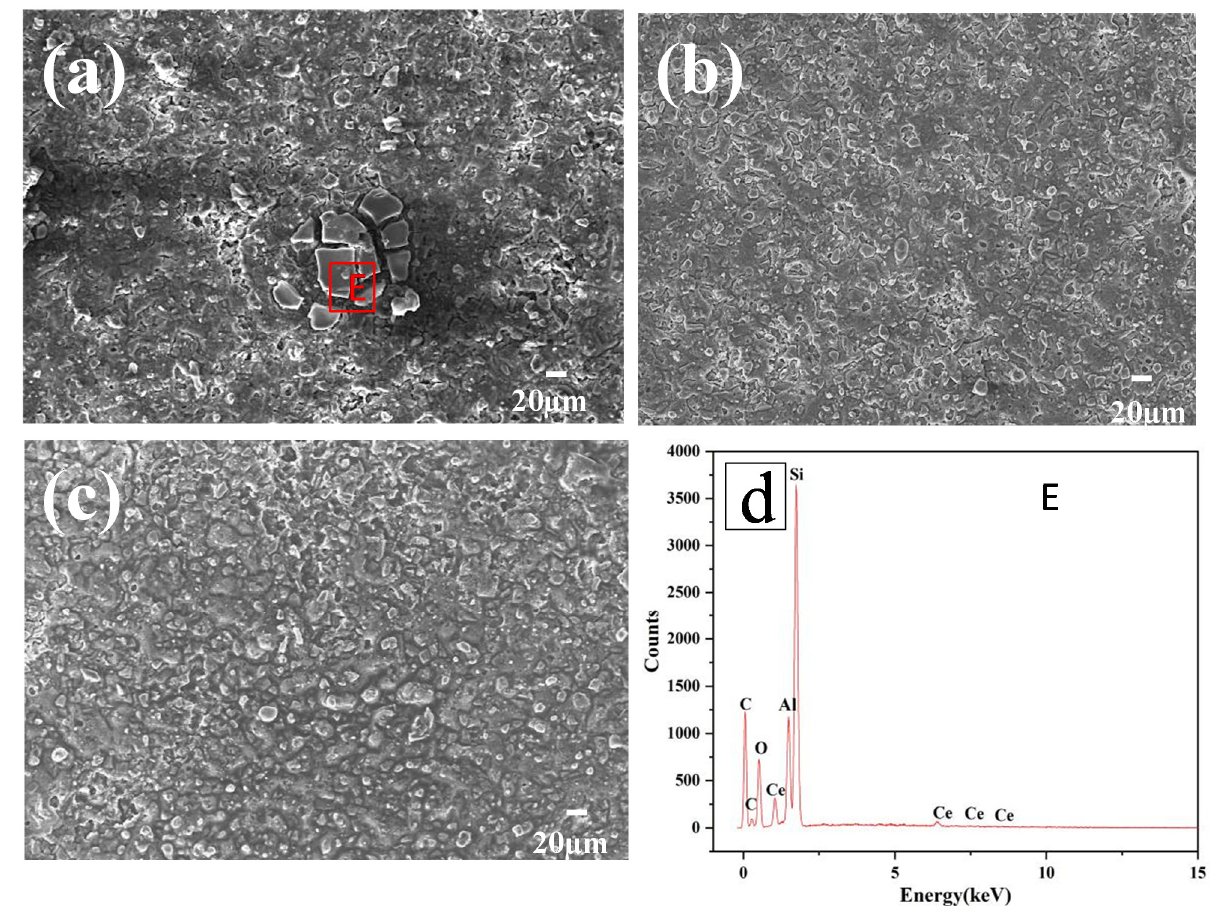
Figure 7. Typical SEM image of Al-20SiC-0.3CeO 2 sample after electrochemical test: ( a ) 5 pulses, ( b ) 15 pulses, ( c ) 25 pulses, and ( d ) EDS C region results.